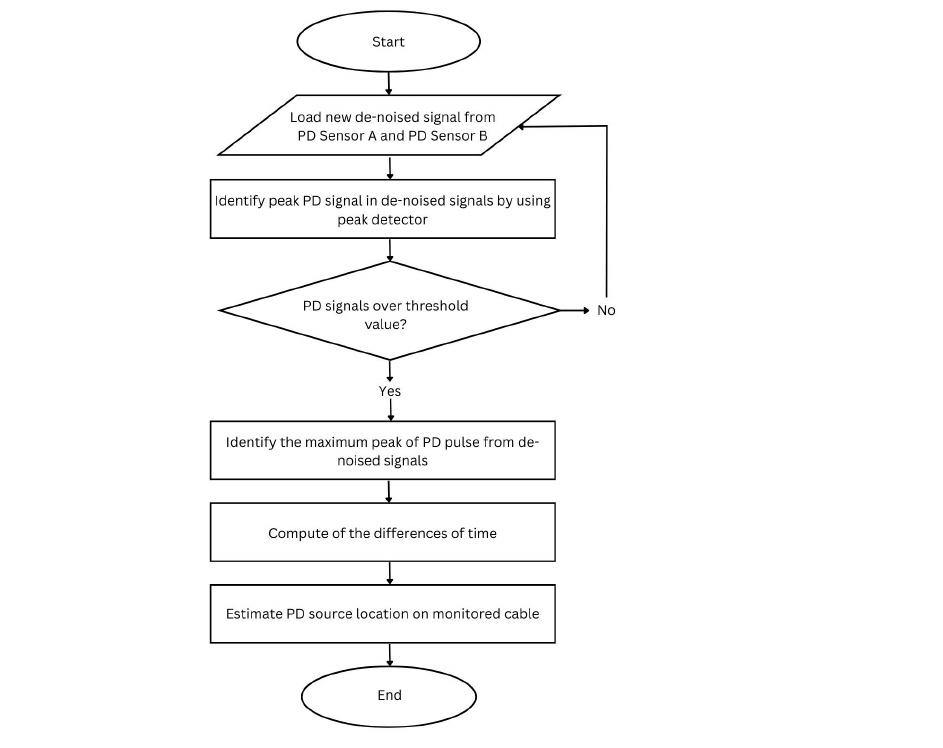
Figure 4. Process flow of the MPD algorithm.